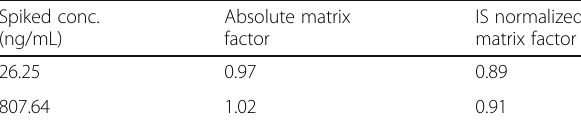
Table 2 Absolute and IS normalized matrix effect of lenalidomide in human plasma